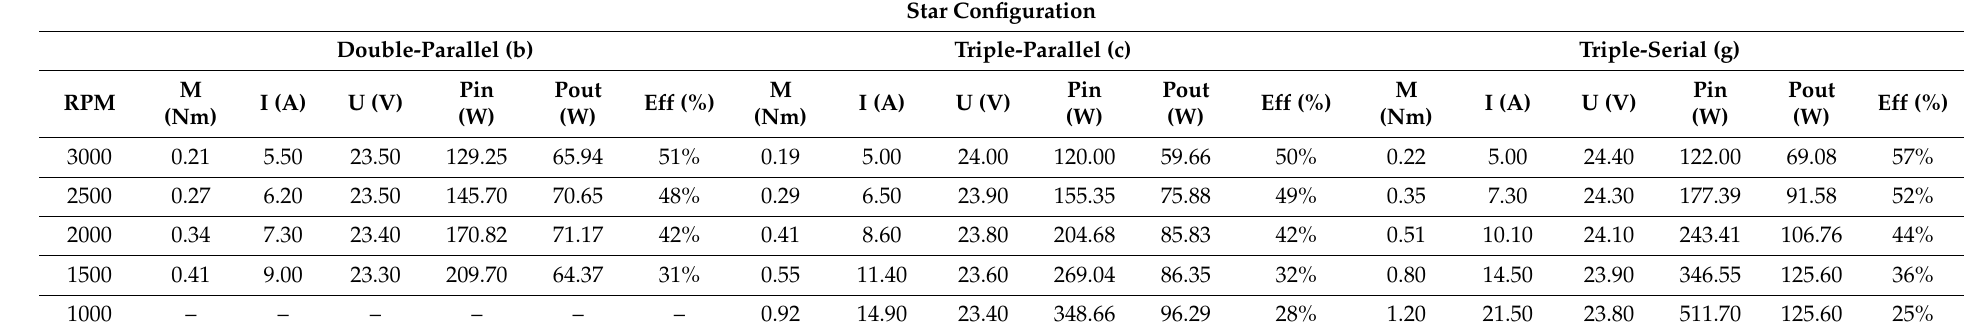
Table 1. Measured results of star inner winding configurations.